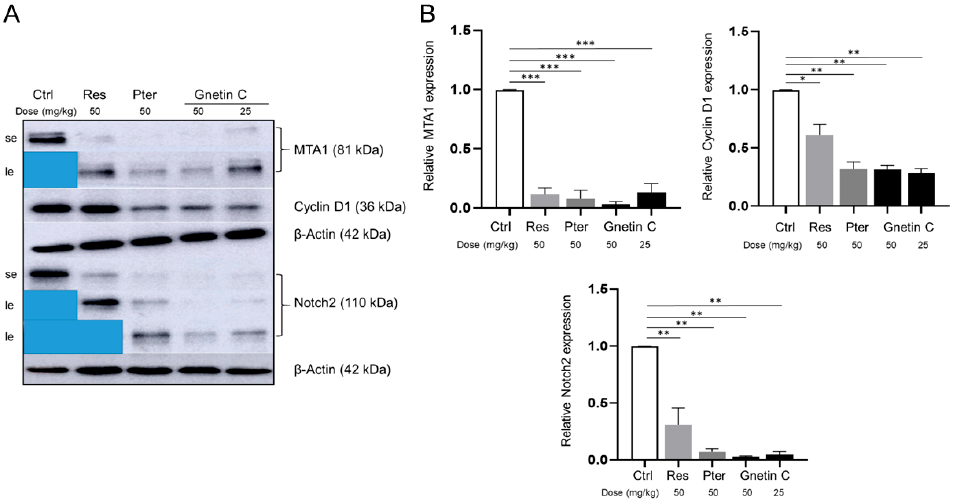
Figure 6. Gnetin C inhibits MTA1, Cyclin D1, and Notch 2 in PC3M-Luc s.c. xenografts. Representative immunoblot images ( A ) and densitometric analysis ( B ) of MTA1, Cyclin D1 and Notch2 levels detected in tumor tissues. Se, short exposure; le, long exposure. Values are means ± SEM of three independent experiments. β -Actin was a loading control. * p < 0.05; ** p < 0.01; *** p < 0.001 (two-way ANOVA).